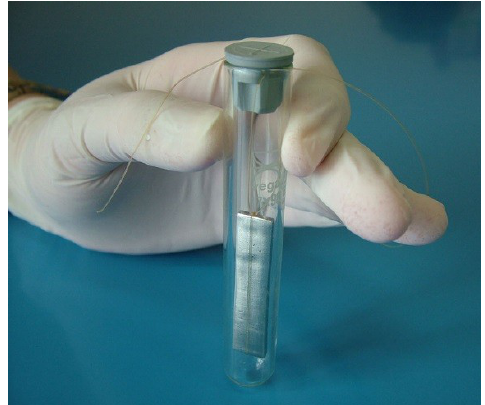
Figure 4. Specimen in glass container suspended on a nylon